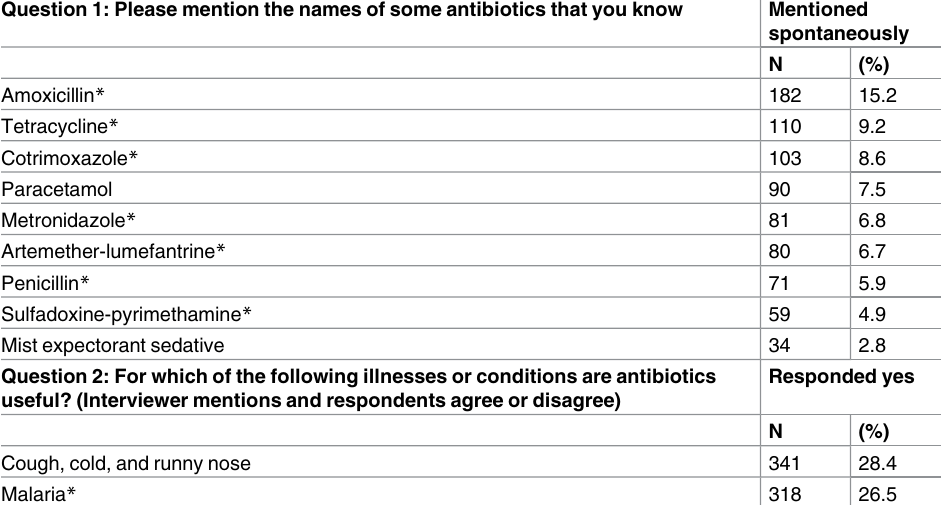
Table 2. Responses to Questions about antimicrobials and antimicrobial resistance **